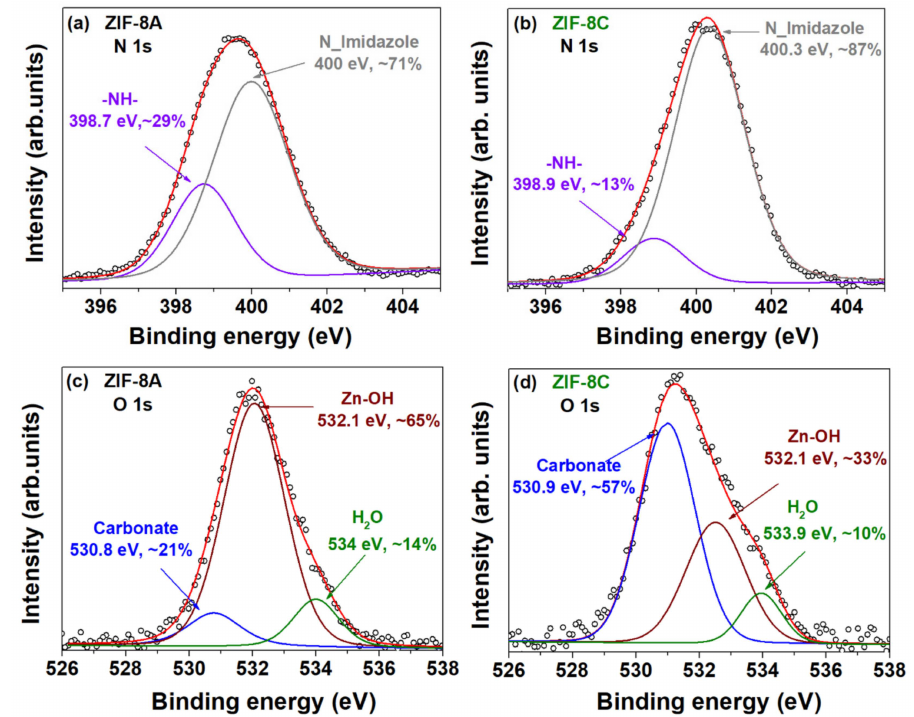
Figure 7. N 1s XPS spectra of ( a ) ZIF-8A and ( b ) ZIF-8C, and O 1s XPS spectra of ( c ) ZIF-8A and ( d )